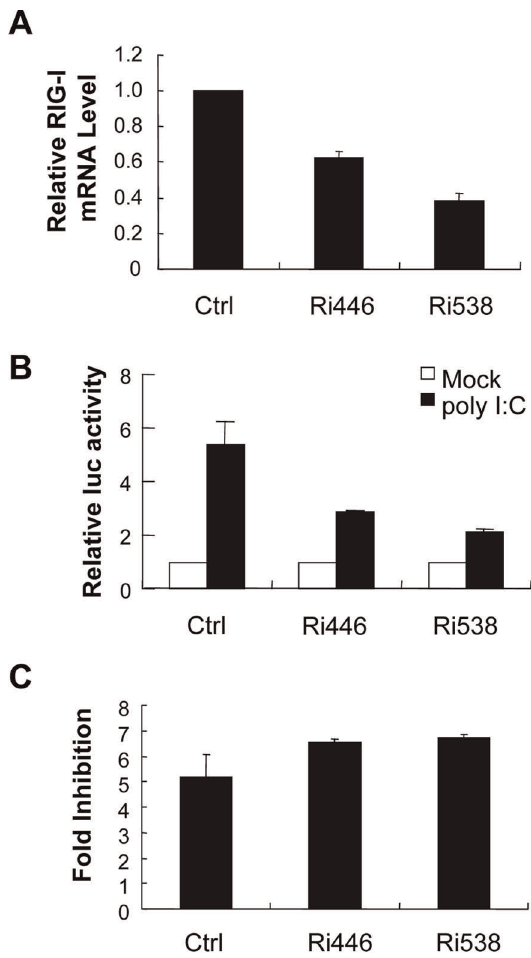
Figure 4. Downregulation of RIG-I does not affect ZAP’s antiviral activity against XMRV-luc. (A) Control shRNA and shRNAs against RIG-I (Ri446 and Ri583) were stably expressed in 293TRex-hZAP- v2 cells. RIG-I mRNA levels were measured by real-time PCR and normalized to that of GAPDH. Data presented are means 6 SE of three parallel experiments. (B) Cells were transfected with pGl3-IFN b -luc and pRL-TK. At 48 h posttransfection, cells were transfected with poly (I:C). Luciferase activity was assayed 12 h later. (C) Cells were infected with XMRV-luc, mock treated or treated with tetracycline for 48 h to induce ZAP expression, and luciferase activities were measured. Fold inhibition was calculated as the luciferase activity in mock treated cells divided by that in tetracycline treated cells. Data presented are means 6 SE of three parallel experiments.